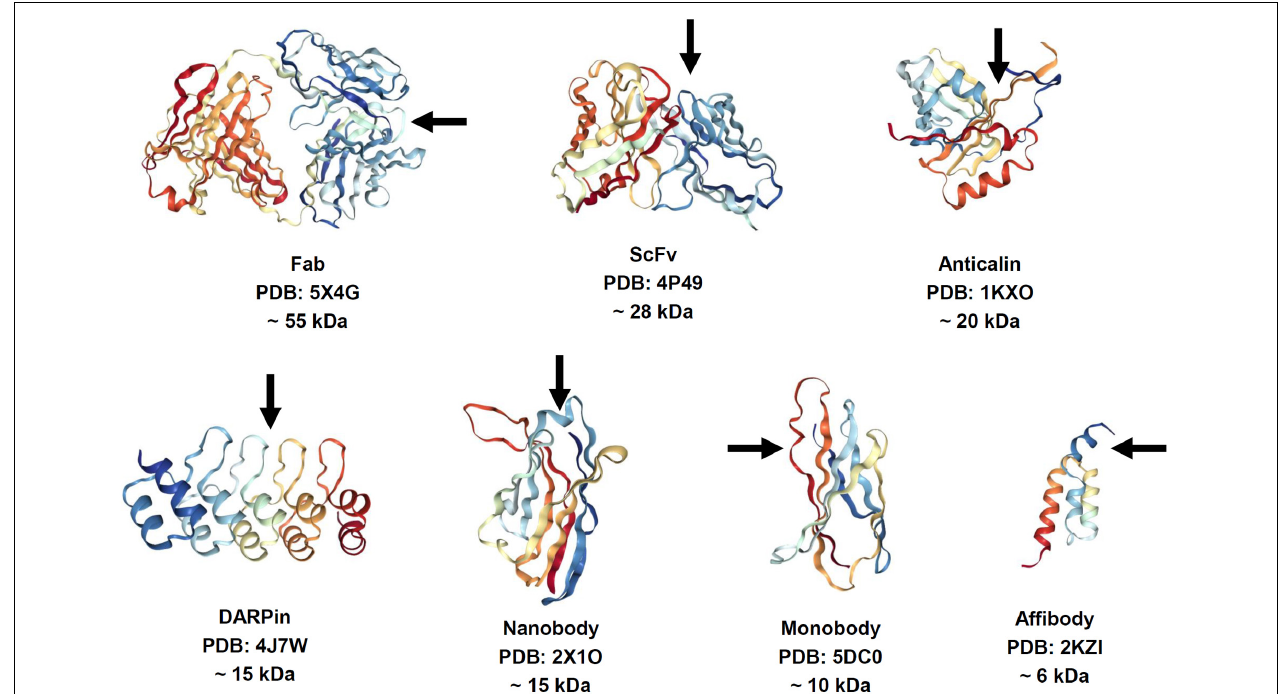
FIGURE 1 | Structure of antibody fragments and alternative antibody scaffolds described in this review. Structures were generated by using NGL Viewer (doi: 10.1093/nar/gkv402). Rainbow color scheme: blue is the N-terminus and red is the C-terminus. Arrows depict antigen binding sites.